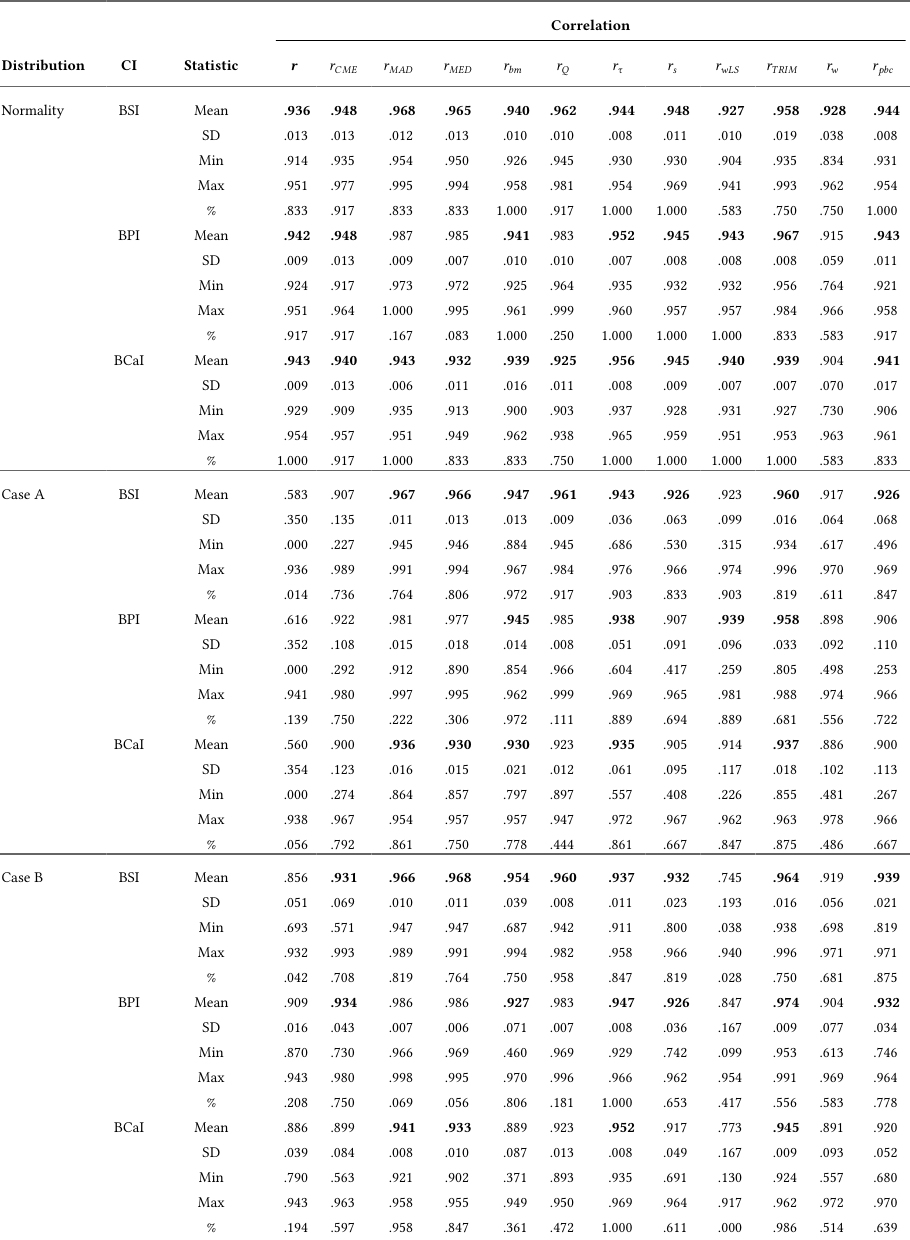
Coverage Probabilities of the Bootstrap CIs (i.e., BSI, BPI, and BCaI) under Normality and Cases A to D